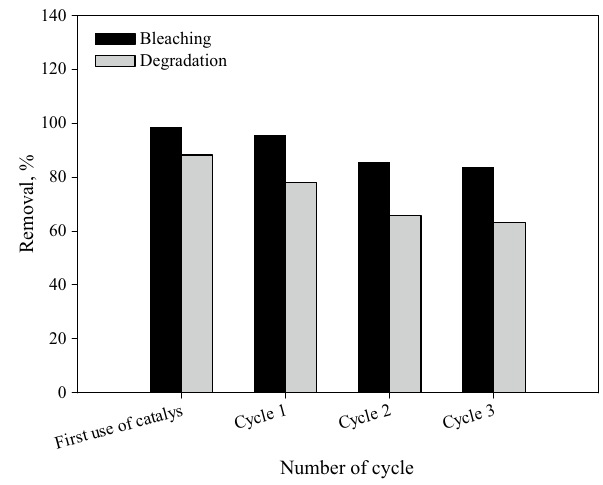
Fig. 16 Effect the number of cycles photocatalyst recovery on the rate bleaching and dye degradation of MO. pH 6, 200 mg L −1